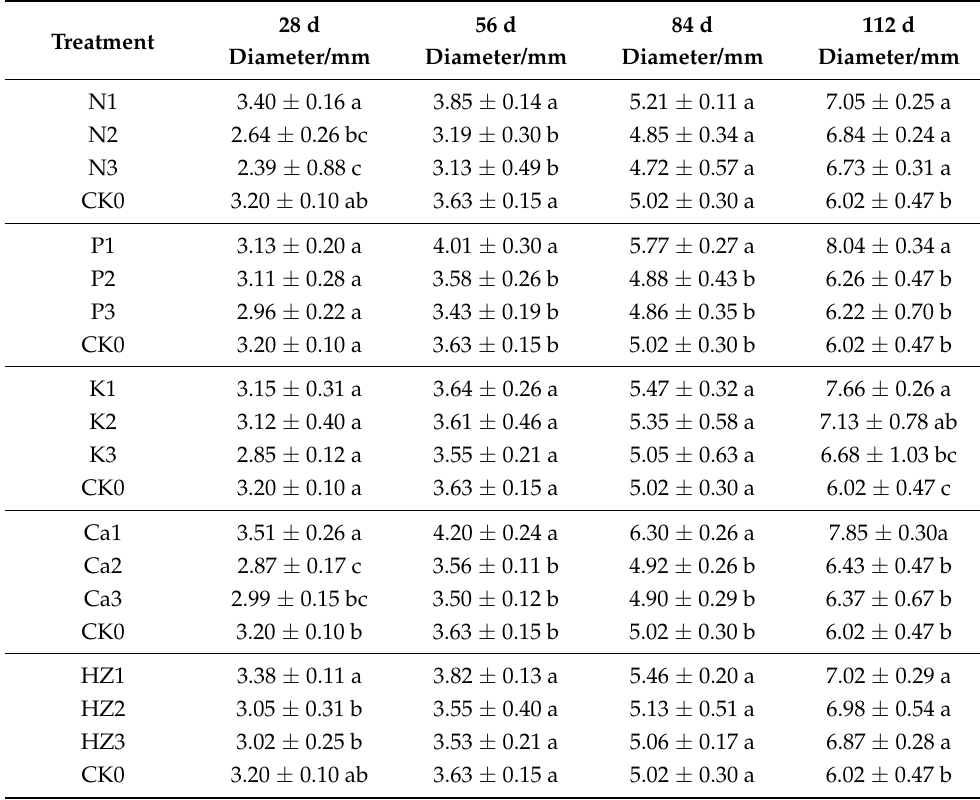
Table 3. Seedling diameter of Z. bungeanum after soil